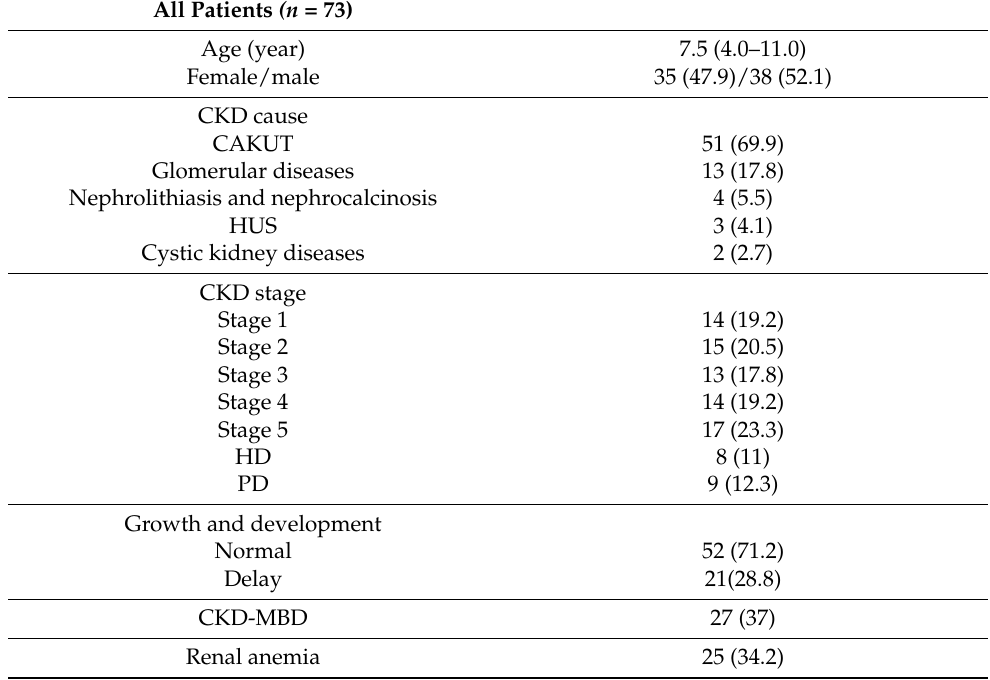
Table 1. Demographic and clinical data of the study population. CKD, chronic kidney disease; CAKUT, congenital anomalies of kidney and urinary tract; HUS, hemolytic uremic syndrome; HD, hemodialysis; PD, peritoneal dialysis; CKD-MBD, chronic kidney disease—mineral and bone disorder. All Patients (n =